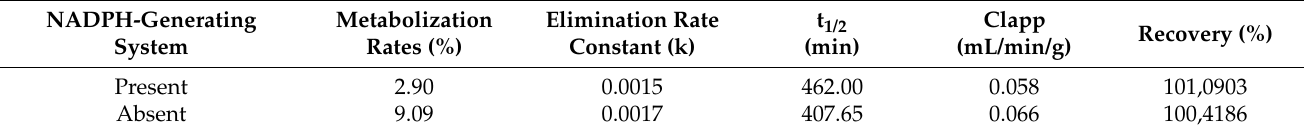
Table 6. Microsomal metabolic stability of LASSBio-2252 ( 5f ) in rat liver